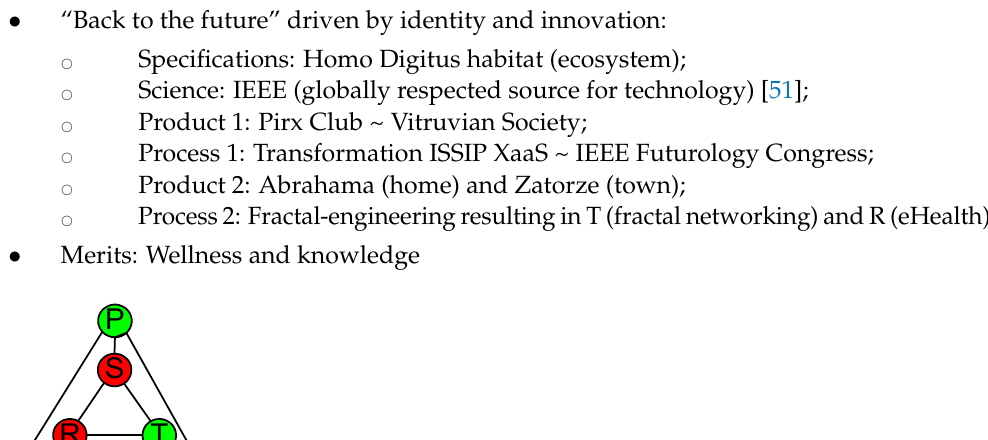
Figure 11. Evil ideology with failed R and S but working T showing improvement.